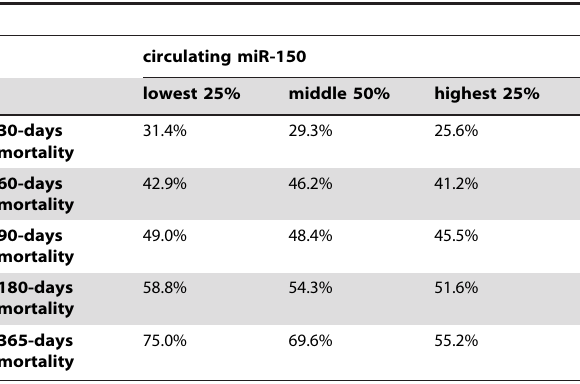
Table 4. Mortality of critically ill patients in relation to their miR-150 serum concentrations at ICU admission to the